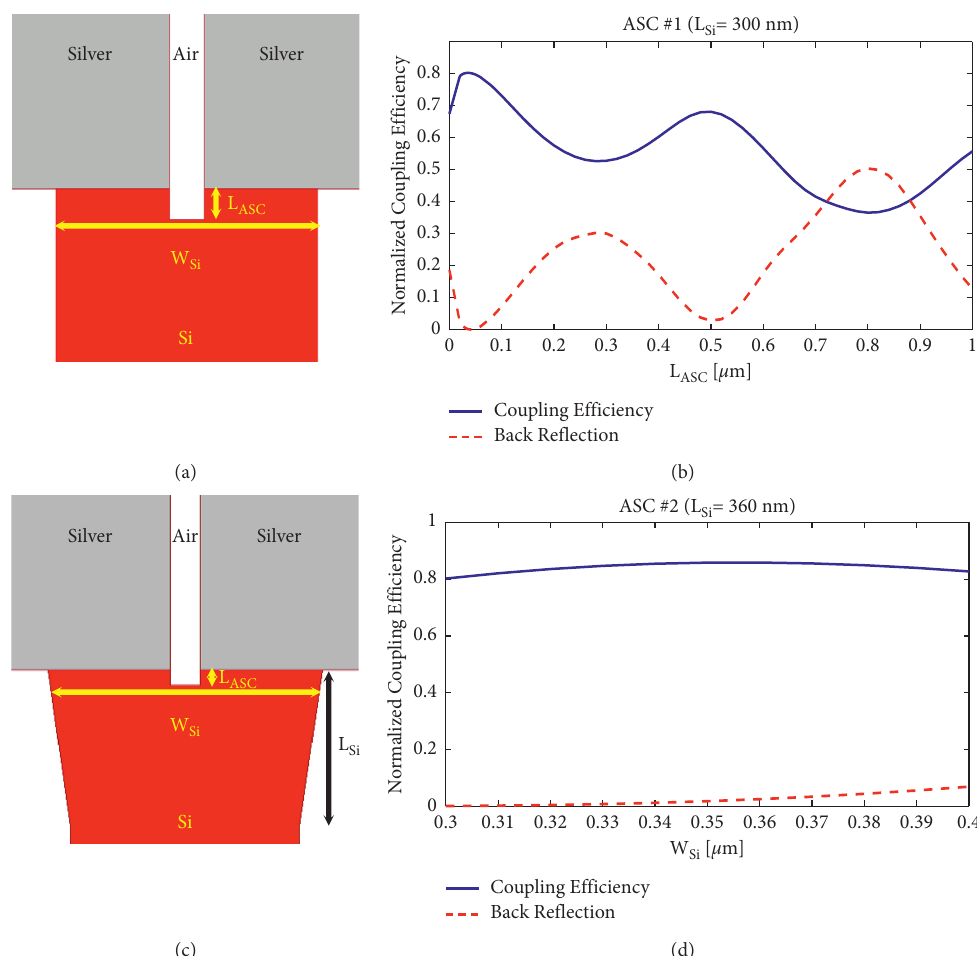
Figure 1: The schematics of the proposed ASCs #1 and #2 that show how light couples into the MDM plasmonic waveguide: (a) ASC #1 without the dielectric width expansion, (b) coupling efficiency as a function of the length of the ASC, L ASC , for ASC #1, (c) ASC #2 with the dielectric width expansion, and (d) coupling efficiency as a function of the width of the CDW, W